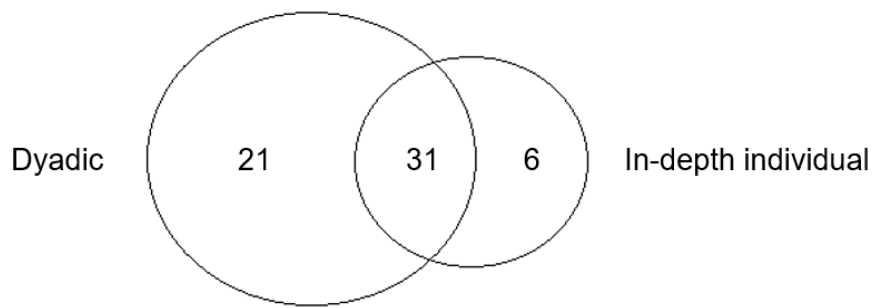
Figure 1. Overlap of attributes retrieved using each method.